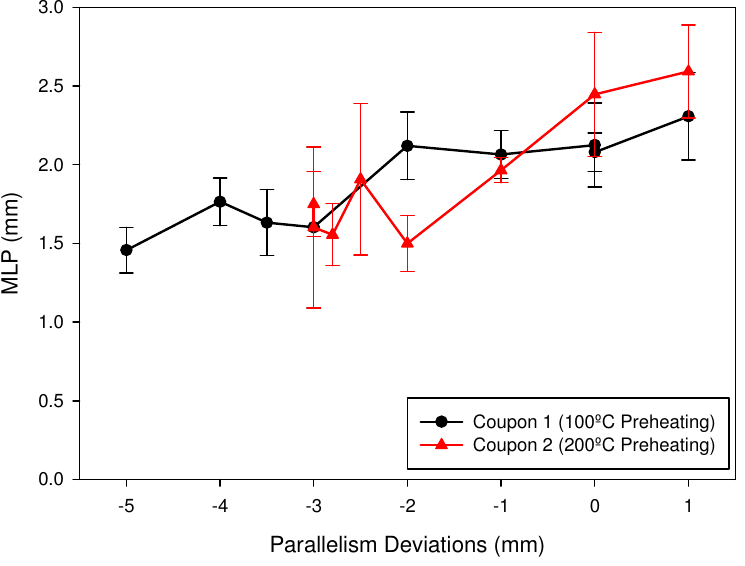
Figure 16. Minimum Leakage Path (MLP) measured for the analyzed coupons. Figure 17 shows the variation of the length of the weld leg ( A f ) as a function of the parallelism deviation for the two coupons analyzed. It can be observed that, with the preheating of 100 ◦ C (black line), there was a significant decrease in A f for deviations higher, in absolute values, to − 2 mm. In the case of the preheating of 200 ◦ C (red line), this decrease was important for deviations greater, in absolute values, than − 1 mm. In both cases, the interval between − 1 and 1 mm around the optimum distance allowed to reach the values of A f required by the standard (2.7 in our